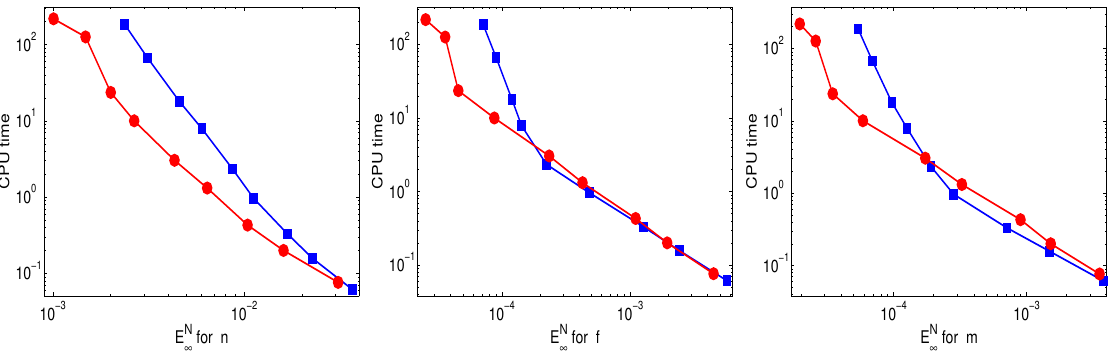
Figure 1. Accuracy in maximal discrete norm versus the CPU time in logarithmic scale for DP 1.1– DP 1.3 (circles) and EUS (squares), Example 4.